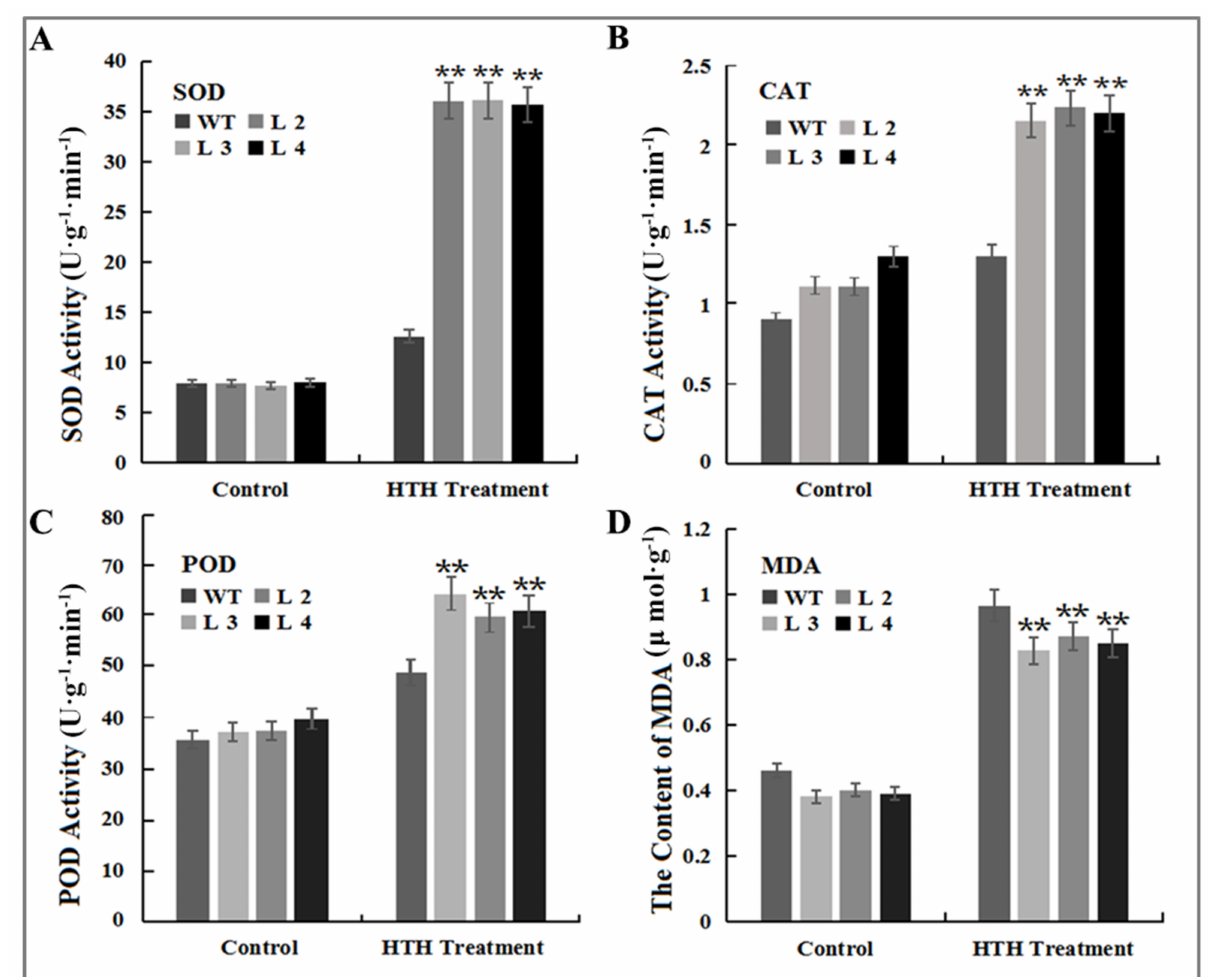
Figure 7. Antioxidant enzyme activities and MDA content in leaves of wild-type (WT) and overex- pression transgenic Arabidopsis lines (L3, L4, and LS5) under HTH stress conditions. ( A ) Superoxide dismutase (SOD); ( B ) Catalase (CAT); ( C ) Peroxidase (POD); ( D) Malondialdehyde (MDA). ** denotes significance at p < 0.01 level, according to Tukey’s correction ( p < 0.01); vertical bars indicate standard errors of each mean value (n =